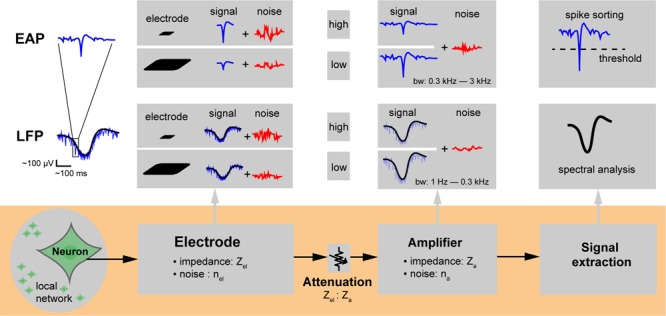
Extracellular recording chain. Microelectrodes for extracellular action potential (EAP) and local field potential (LFP) signal recording. The neuronal signals of interest are attenuated along the overall recording chain and may be compromised through injected noise or interfering signals until they get digitized and stored for analysis. The electrode size affects the spatial signal averaging, which determines and the capability to resolve local features of specific neuronal cells. The impedance of the electrode (Zel) depends mainly on its overall surface area and material and determines the electrode noise (nel); the ratio of electrode to amplifier input impedance (Zel: Za) directly affects signal attenuation. Background neuronal activity or undesired EAPs from distant neuronal sources (local network) give rise to noise. The size of the electrodes also determines how much of the background activity is picked up.